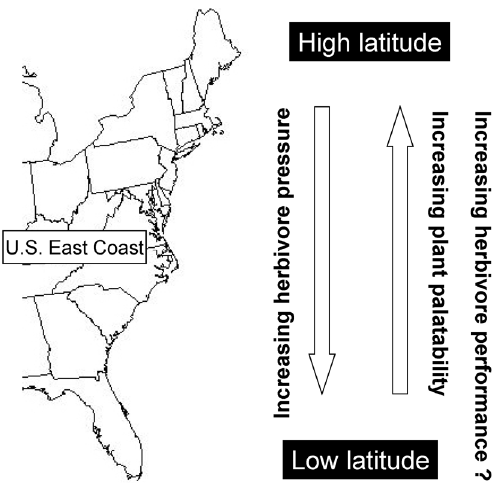
Figure 1. Known and hypothesized plant-herbivore interac- tions across latitude in salt marshes on the U.S. Atlantic Coast. This study tested if increased plant palatability predicts better herbivore performance at high latitudes.